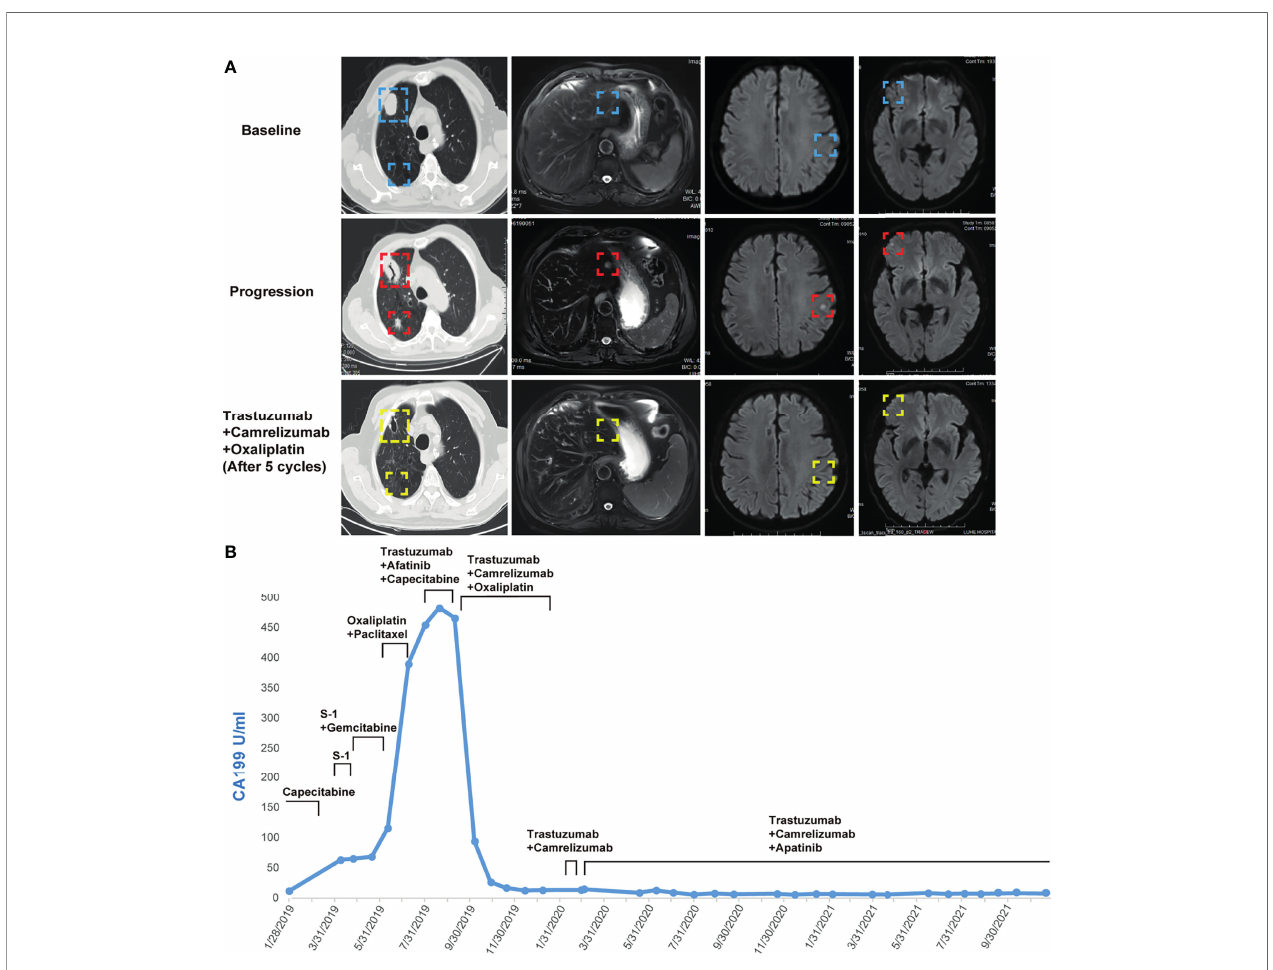
FIGURE 2 | (A) Computed tomography and MRI images showing the patient ’ s baseline disease, progression on S-1 plus gemcitabine in the liver metastatic lesion, progression on trastuzumab plus afatinib and capecitabine in the brain and lung metastatic lesions, and response to camrelizumab plus trastuzumab and oxaliplatin in the liver, brain, and lung metastatic lesions. (B) Dynamics of cancer antigen 199 (CA199) (U/ml) levels during the entire disease